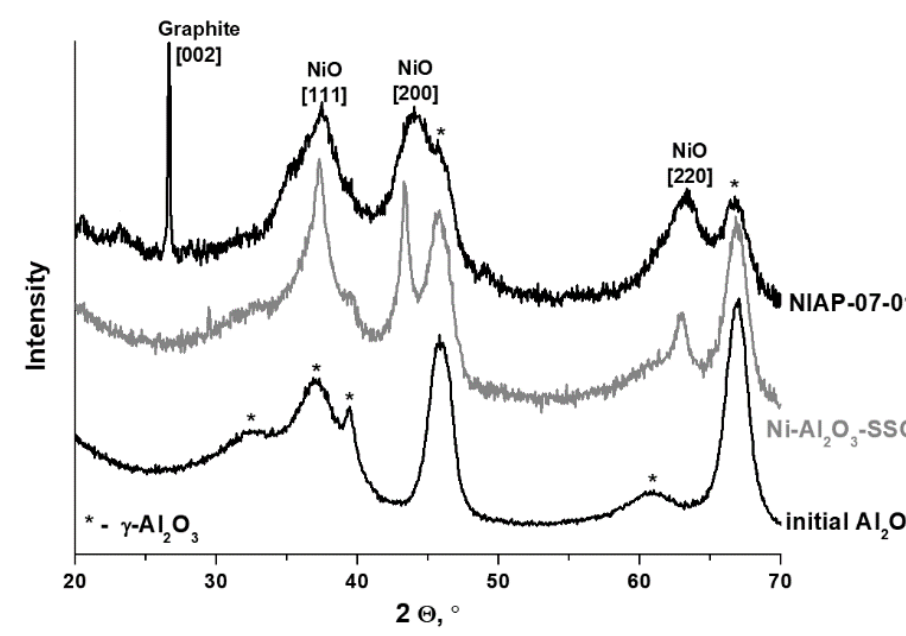
Figure 4. XRD patterns of the NIAP-07-01 and Ni-Al 2 O 3 -SSC catalysts.